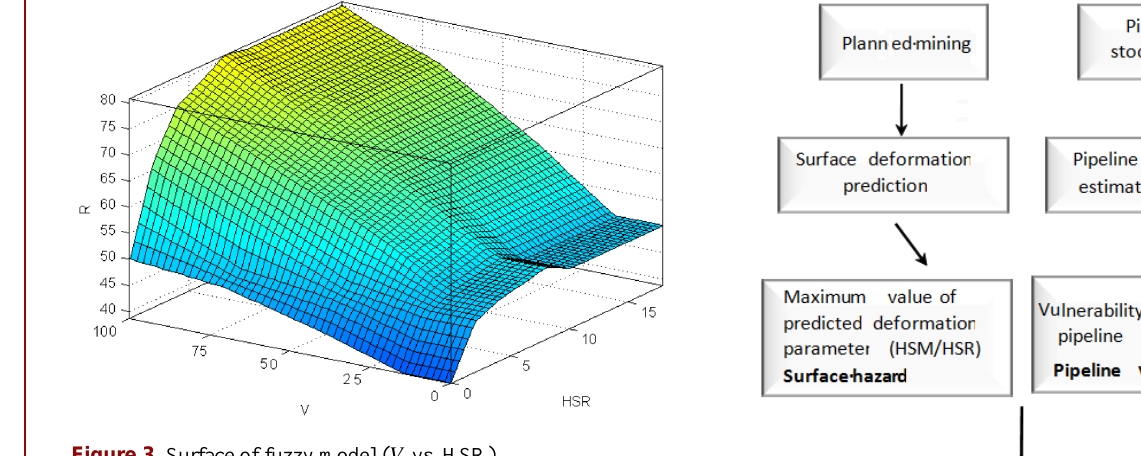
Figure 3. Surface of fuzzy model ( V vs. HSR).